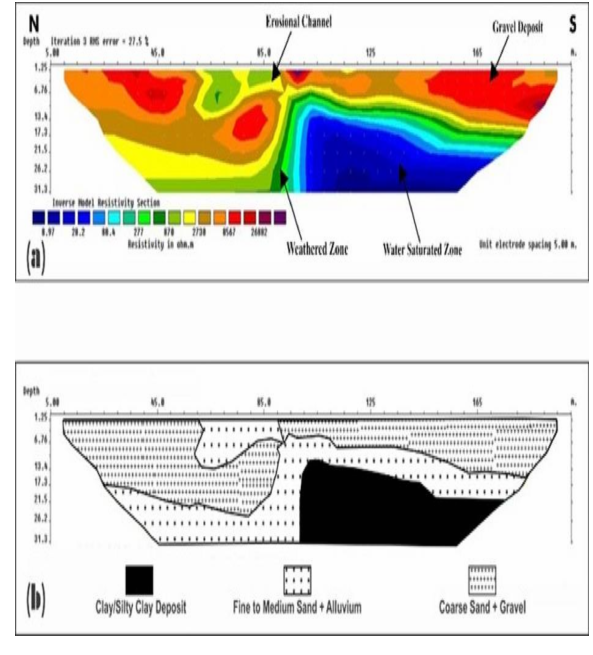
Fig. 10. (a) Profile 9 electrical resistivity tomography; (b) Geologic cross-section interpreted from the resistivity model within a sequence of horizontal sedimentary sequence (see Fig.